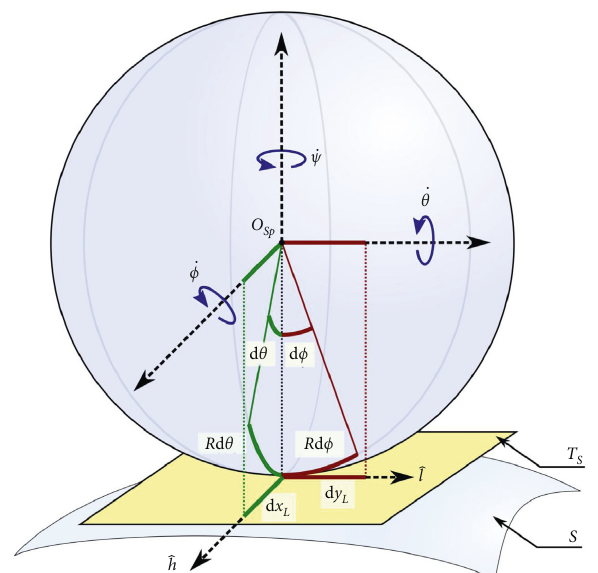
Figure 4: Differential rolling length of a spherical robot using triple-axis rolling during differential of time, dt , along 􏽢 h and 􏽢 l